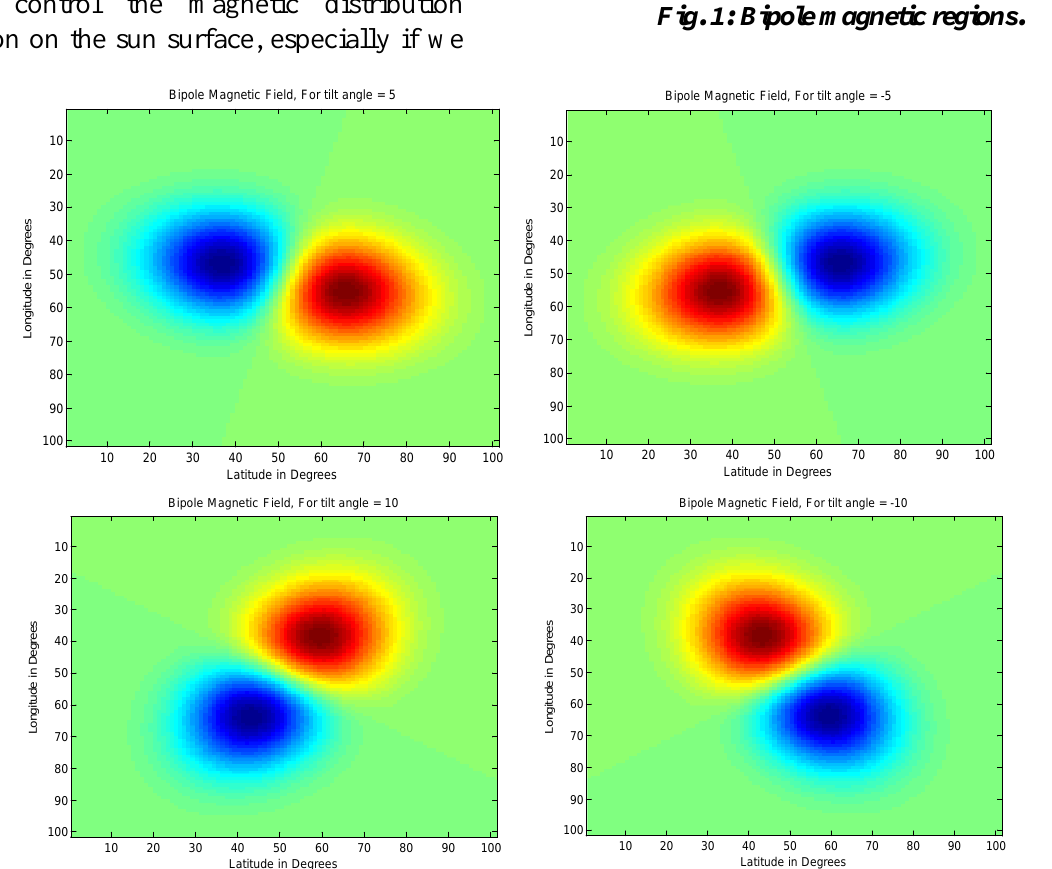
Fig. 1: Bipole magnetic regions.